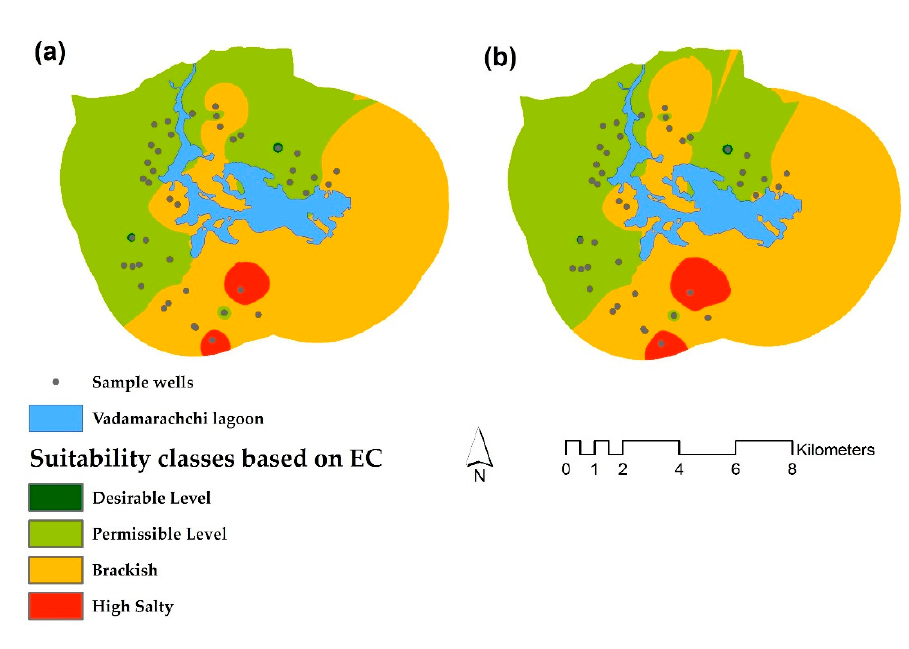
Figure 3. Distribution of drinking water suitability classes [28] based on electrical conductivity during the dry season: ( a ) March, ( b ) April, ( c ) May and ( d ) June. 3.2. Water Quality for Irrigation Irrigation water quality influences not only crop yield, but also the soil health. Table 2 shows the guidelines published by FAO [29], and it is possible to allot probable areas to different water types during the dry season. Figure 4 shows the spatial distribution of irrigation water quality based on FAO standards. At the beginning of the dry season, 33% of the area was categorized as having water